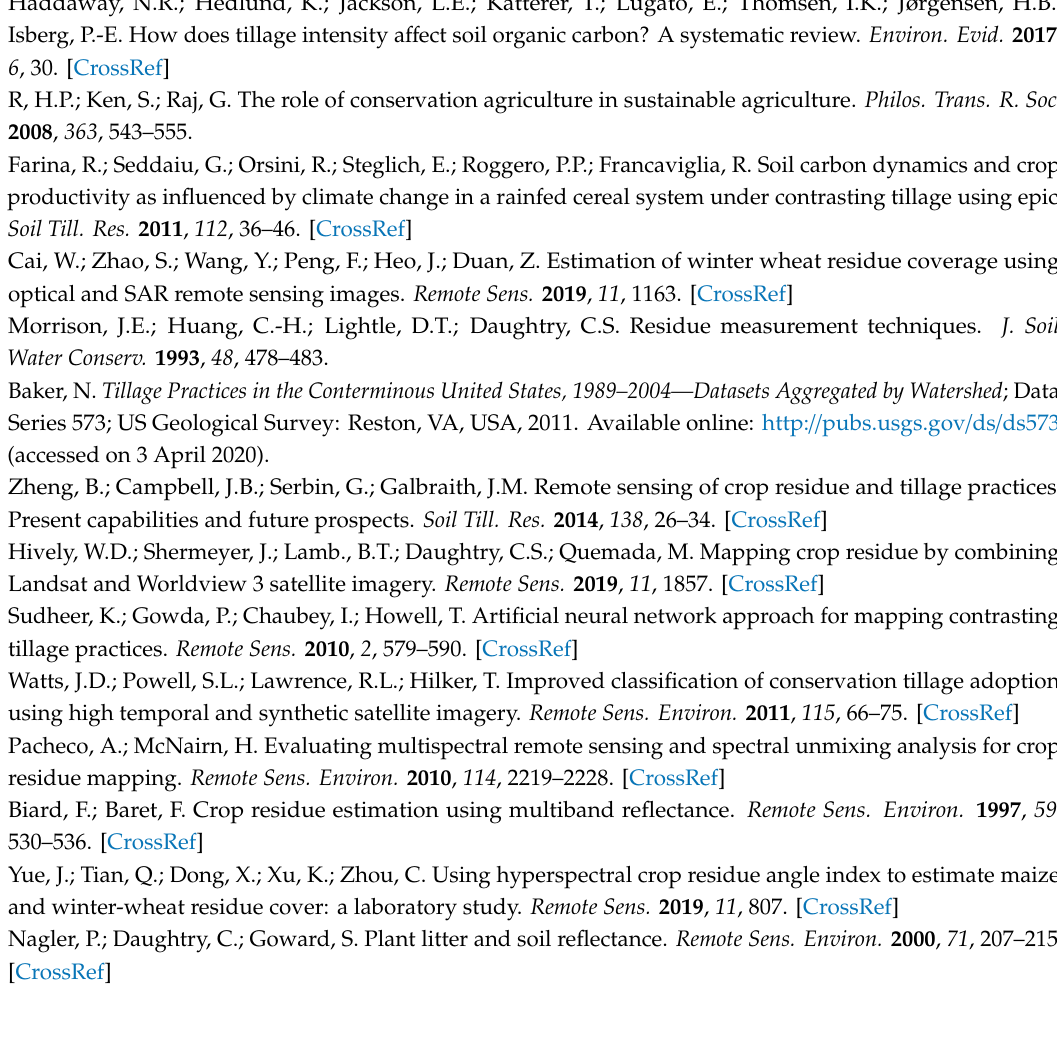
Table S5: The R 2 cv and RMSE cv (%) values for each fold of the 10-fold cross-validation of the univariate regressions based on MSI bands. Table S6: The continuation of Table S5. Table S7: The R 2 cv and RMSE cv (%) values for each fold of the 10-fold cross-validation of the univariate regressions based on CRIs. Table S8: The continuation of Table S7. Table S9: The continuation of Table S8. Table S10: The R 2 cv and RMSE cv (%) values for each fold of the 10-fold cross-validation of the univariate regressions based on textural features. Table S11: R 2 cv and RMSEcv (%) values for each fold of the 10-fold cross-validation of the five ML approaches with 9 bands and 4 mean textural features as input